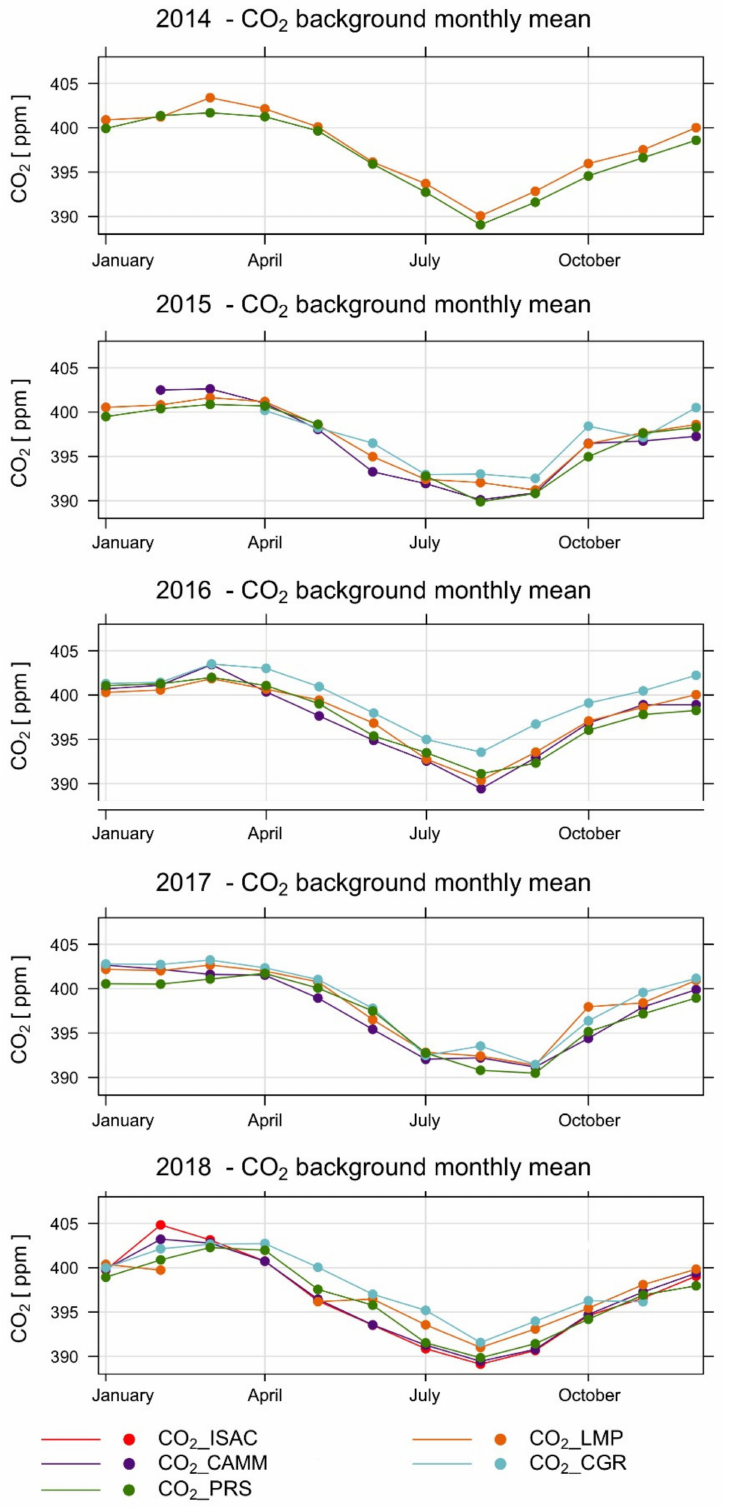
Figure 6. Annual CO 2 cycles (monthly mean values) at PRS (green), CMN—CAMM (purple), CMN— ISAC (red), CGR (blue) and LMP